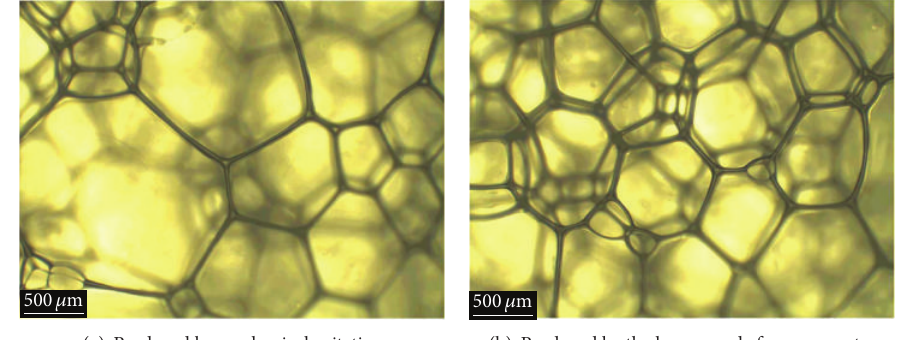
Figure 4: The optical microscopic analysis diagram of aqueous foam.